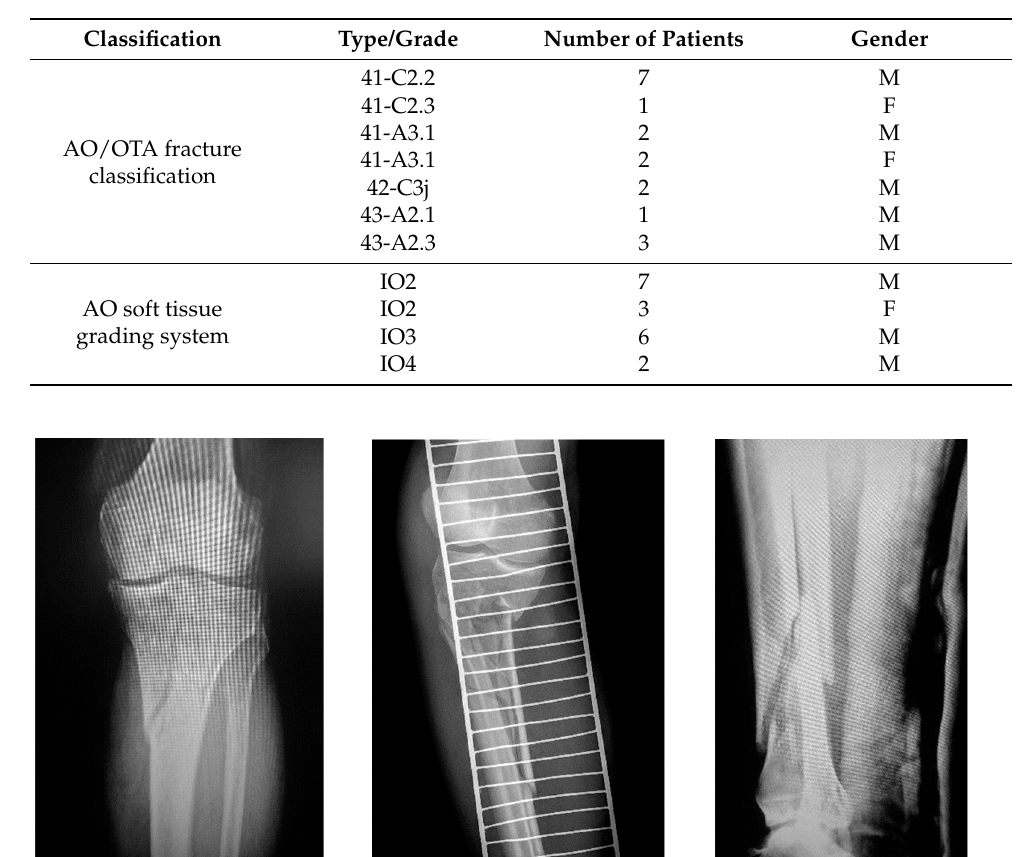
Table 1. Patients and fracture characteristics.